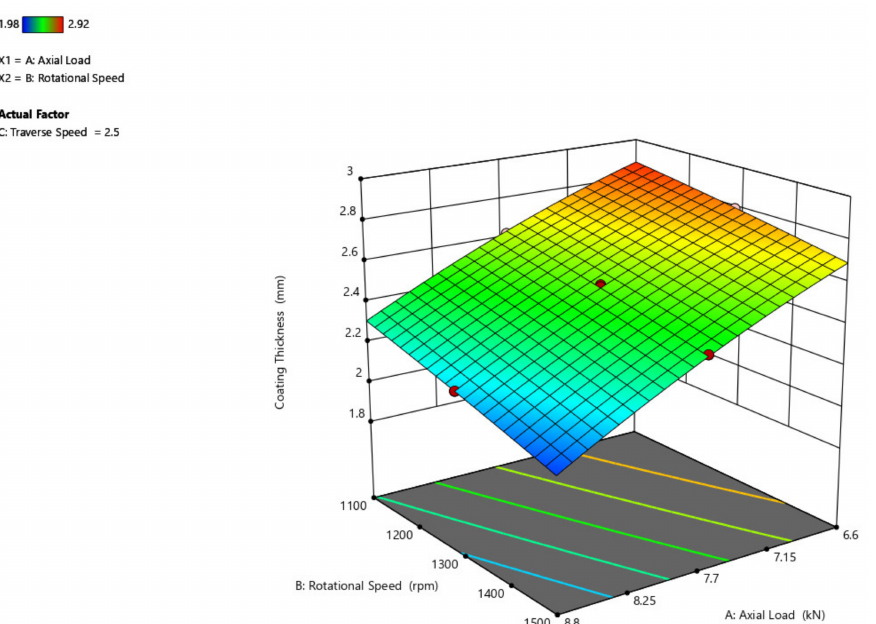
Figure 5. Interaction plot of axial load and rotational speed on coating thickness (C t ). In comparison to the axial load and rotational speed, the traverse speed has no detrimental influence on the thickness of the coating, as shown in Figure 6. Despite the increased traversal speed, the coating thickness stays constant [32]. When the traverse speed is maximum (3 mm/s) and the axial force is maximum (8.8 kN) the thickness of the coating would be minimal.